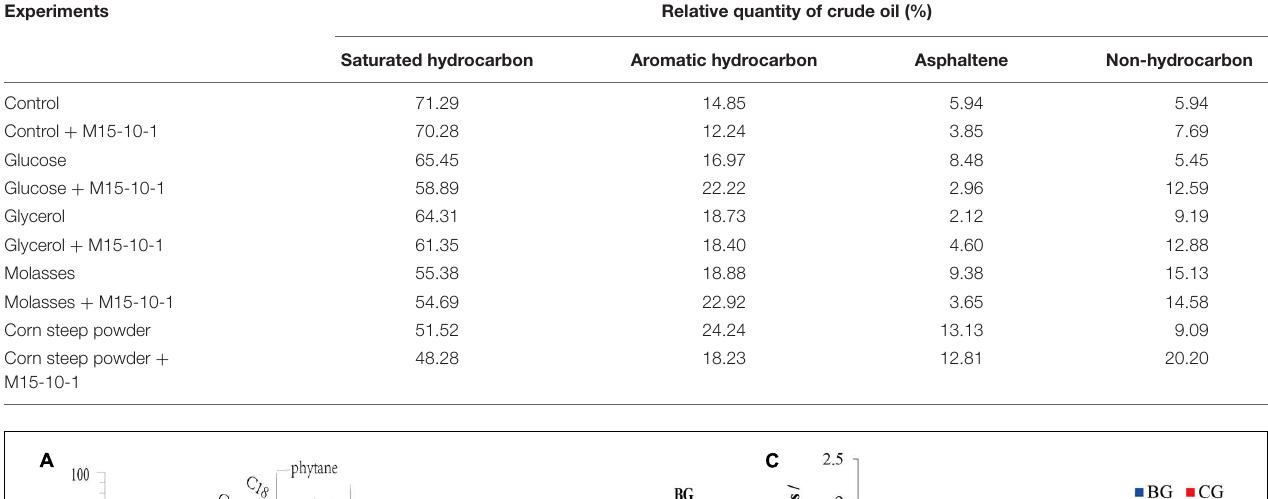
TABLE 3 | Relative quantities of saturated hydrocarbons, aromatic hydrocarbons, asphaltene, and non-hydrocarbons in crude oil before and after stimulation with nutrients or combination with Bacillus subtilis M15-10-1. Experiments Relative quantity of crude oil (%) Saturated hydrocarbon Aromatic hydrocarbon